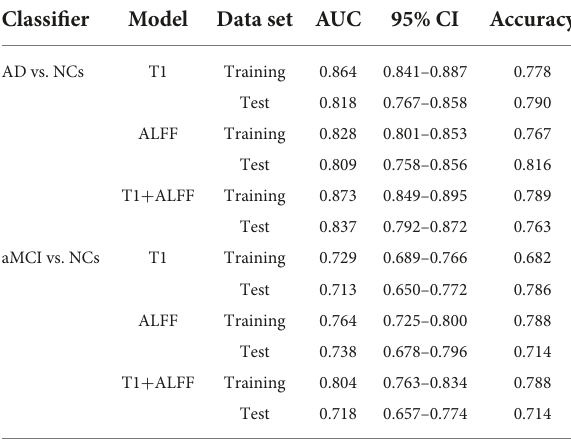
TABLE 2 The ROC curve of left hippocampal structural images, ALFF in slow-5 frequency band and their combined